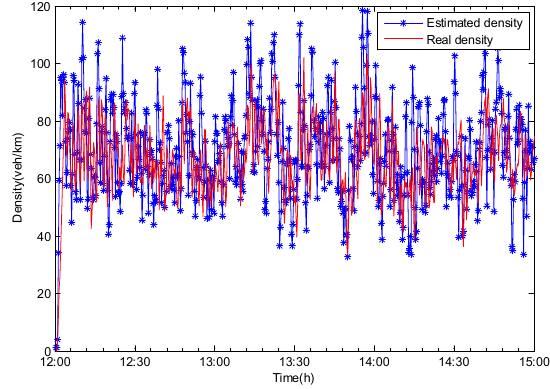
Figure 8. Cell 1 with on-ramp traffic.